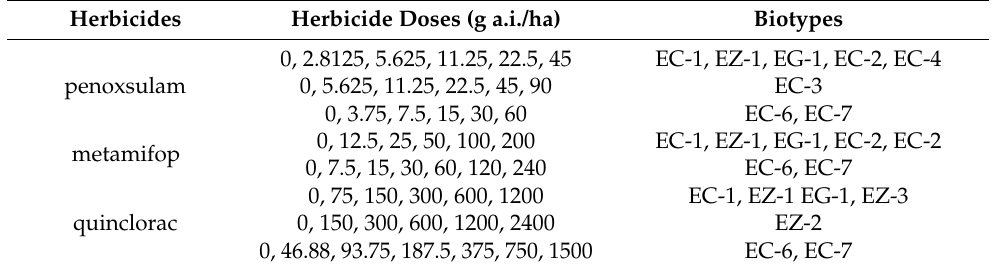
Table 2. Herbicide doses used in whole-plant pot bioassays for the E. spp. populations. Herbicides Herbicide Doses (g a.i./ha) Biotypes